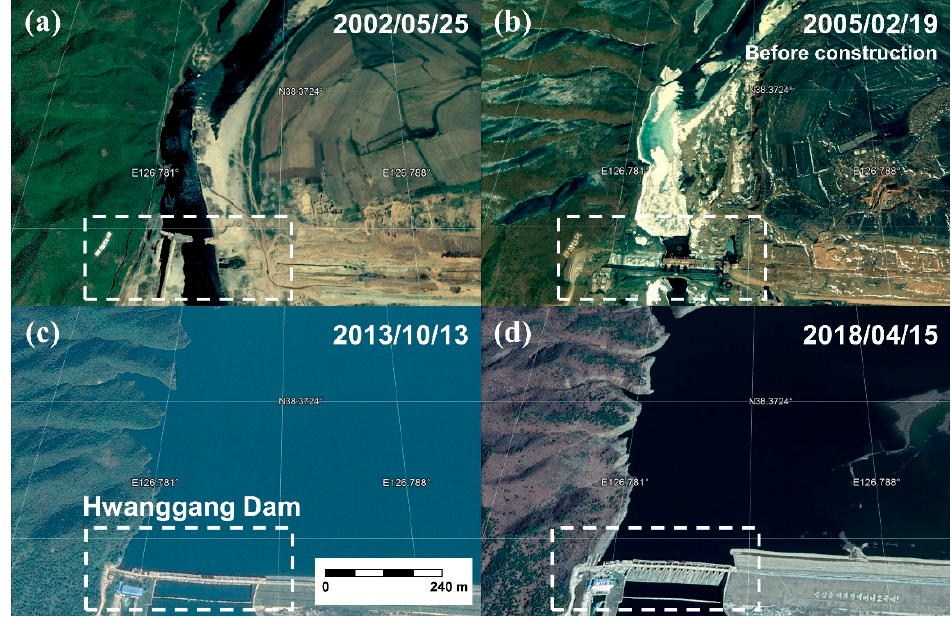
Figure 6. Images of the Hwanggang Dam from 2002 to 2018 (Lat 38.3680° N, Lon 126.7824° E, map data ©2019 Google, Maxar Technologies).